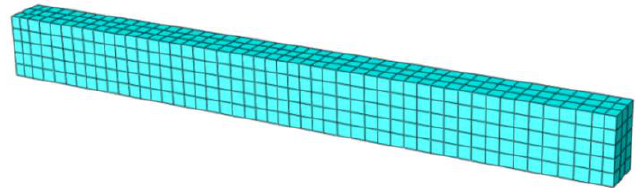
Figure 11. Finite element model and meshing of ceramsite concrete beam.